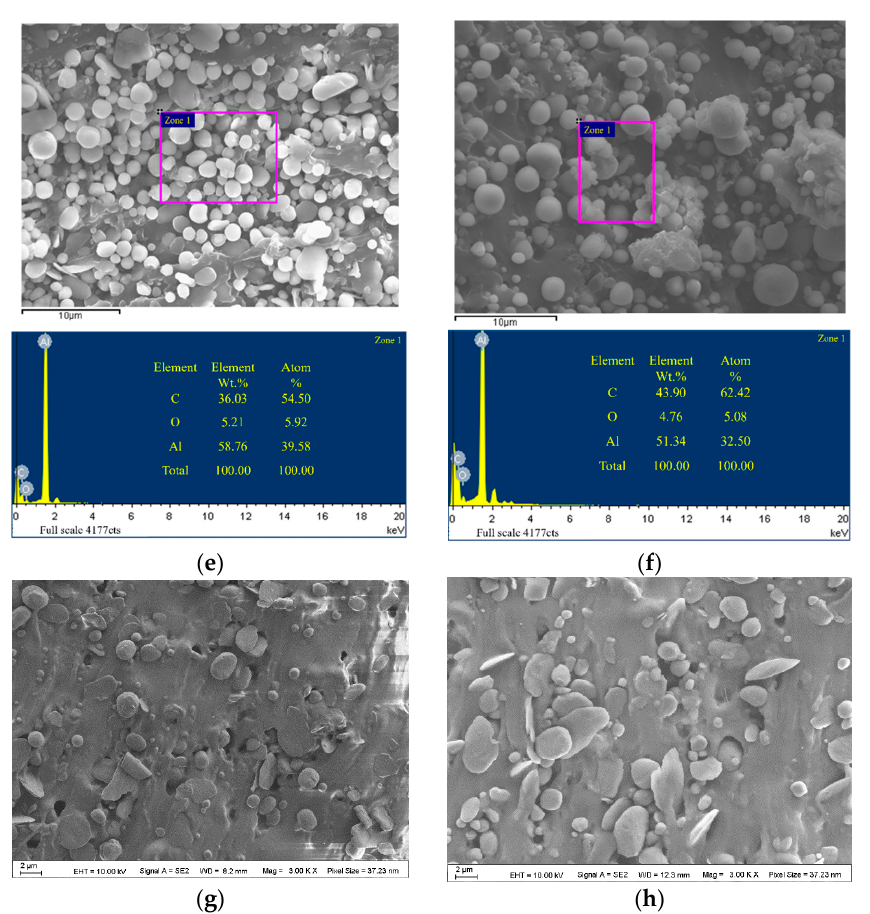
Figure 8. Results of electron microscopy scans of the grain surface. ( a ) 65%Al (front side of grain after test). ( b ) 65%Al (post side of grain after test). ( c ) 58%Al (front side of grain after test). ( d ) 58%Al (post side of grain after test). ( e ) 48%Al (front side of grain after test). ( f ) 38%Al (front side of grain after test). ( g ) 48%Al (front side of grain before test). ( h ) 38%Al (front side of grain before test).